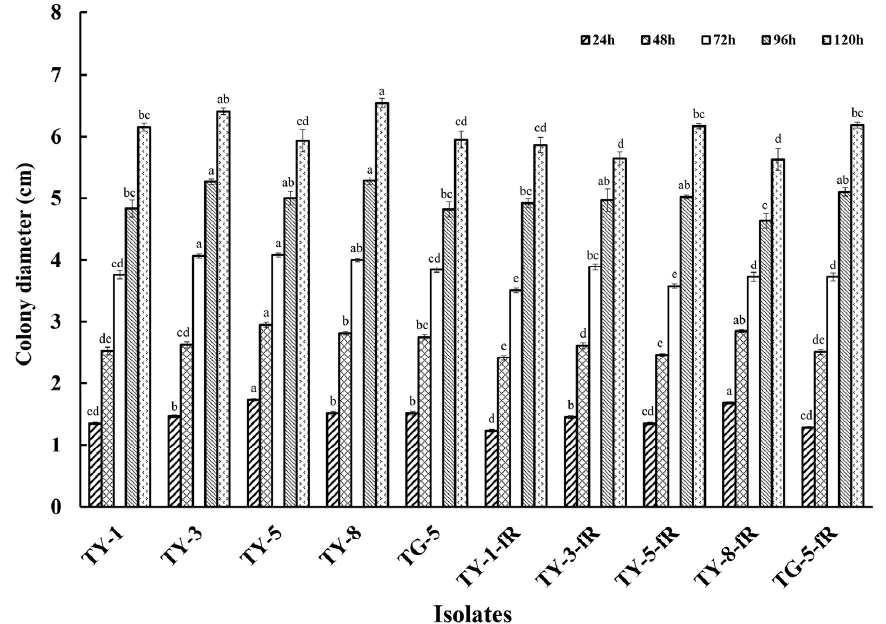
Figure 1. Mycelial growth of five fludioxonil-resistant mutants (TY-1-fR, TY-3-fR, TY-5-fR, TY-8-fR, and TG-5-fR) of FOM in comparison to their sensitive parental isolates (TY-1, TY-3, TY-5, TY-8, and TG-5) when grown on PDA medium at 24 °C. Data are the means of 10 replicates ± SE. Different letters above columns indicate significant differences according to Fisher’s least significant difference test ( p ≤ 0.5).